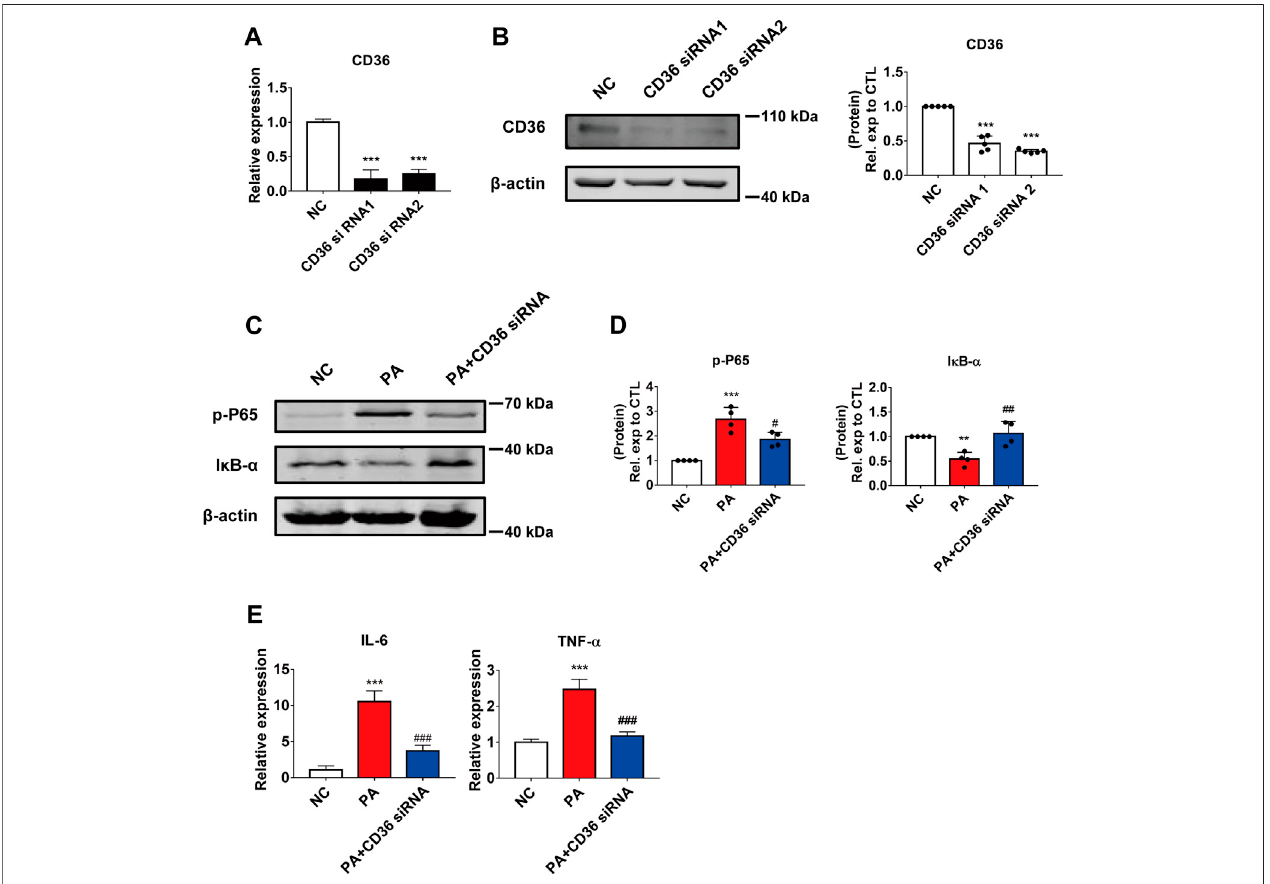
FIGURE3| TheeffectofCD36inPA-inducedcardiomyocytein fl ammation. (A,B) Silencingef fi ciencyofCD36. (A) qRT-PCRanalysisoftheeffectoftransfectionof CD36 siRNA after 24 h in AC16 cells. *** p < 0.001, compared with the negative control (NC) group, n (cid:1) 3. (B) Western blotting analysis of the effect of CD36 siRNA transfection after 48 h in AC16 cells. *** p < 0.001, compared with the NC group, n (cid:1) 5. (C,D) Changes in the intracellular in fl ammatory signaling pathway after CD36 siRNA and PA treatment. (C) Western blotting analysis of the expression of the p-P65 and I κ B- α proteins in human cardiomyocytes; (D) Statistical analysis of protein expression, ** p < 0.01, *** p < 0.001 compared with the NC group; # p < 0.05, ## p < 0.01, compared with the PA group, n (cid:1) 4. (E) qRT-PCR analysis of the expression ofthein fl ammatorygenesIL-6and TNF- α inCD36 siRNAand PA-treated cells. *** p < 0.001,comparedwiththeNC group; ### p < 0.001,comparedwiththe PA group, n (cid:1)